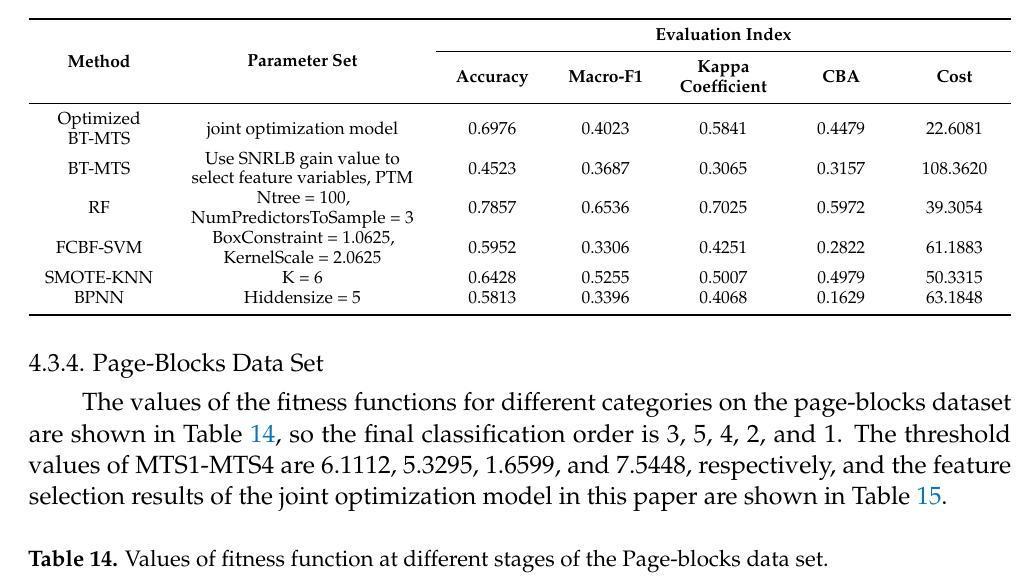
Table 13. Comparison of the classification results of the glass data set of the glass data set.